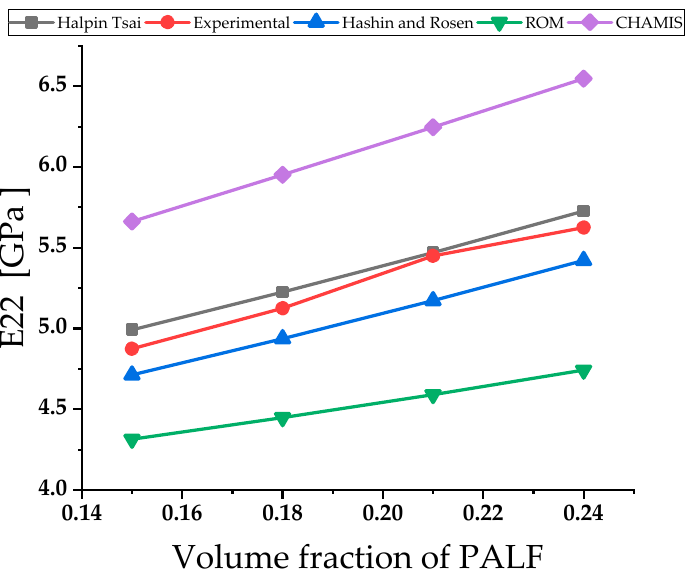
Figure 8. Transverse Young’s modulus E 22 of PALF /epoxy in terms of different volume fractions of fiber.